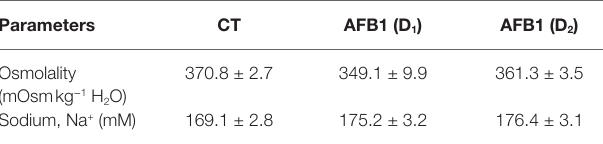
TABLE 2 | Plasma osmolality and sodium in S. aurata juveniles fed with different experimental diets (CT, D 1, and D 2 ) for 85 days. Parameters